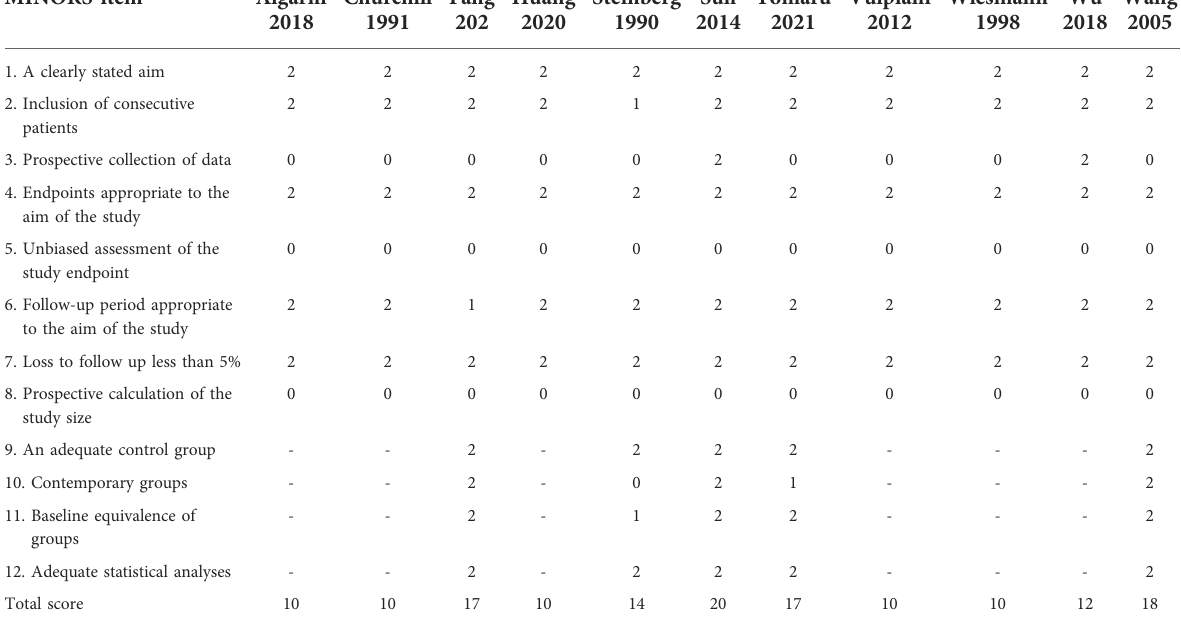
TABLE 3 Results of the MINORS